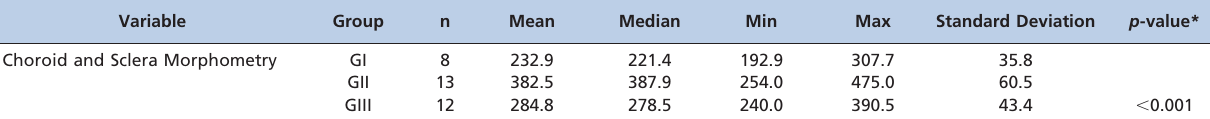
Table 1 - Sclera and choroid thicknesses in